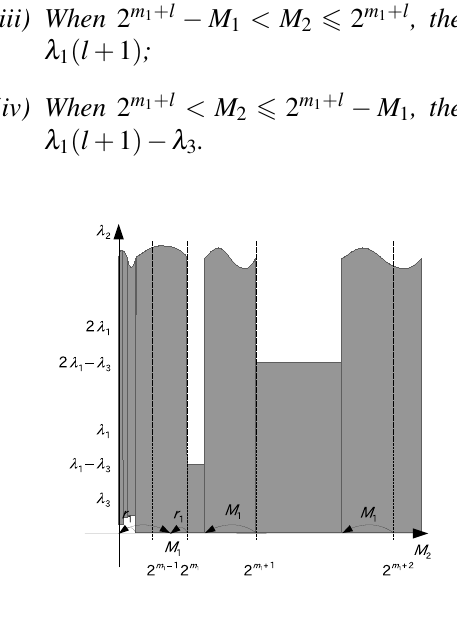
Fig. 8. In the case of λ 2 + λ 3 (cid:54) λ